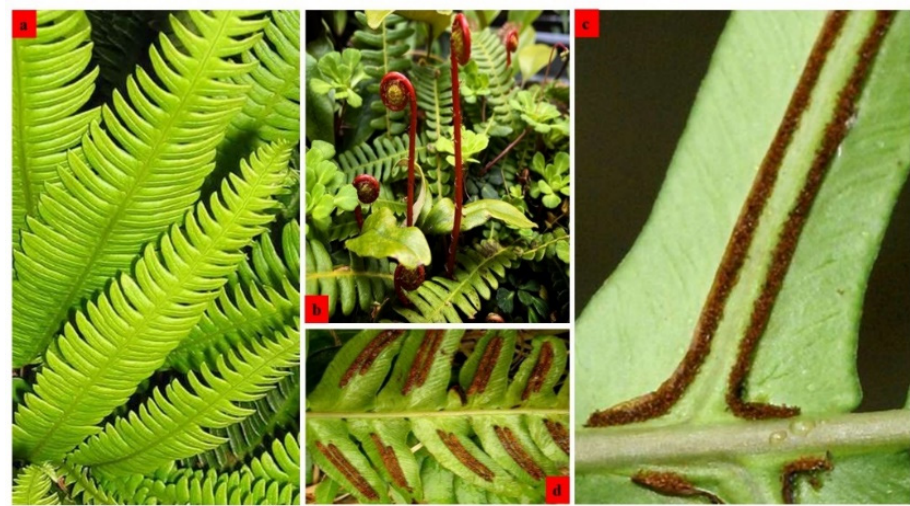
Figure 1. ( a ) Mid-green glossy fronds of Blechnum , ( b ) Oblong leaflets, ( c ) Leaves with sporangia at the adaxial surface, ( d ) Pinnate sterile/fertile fronds.